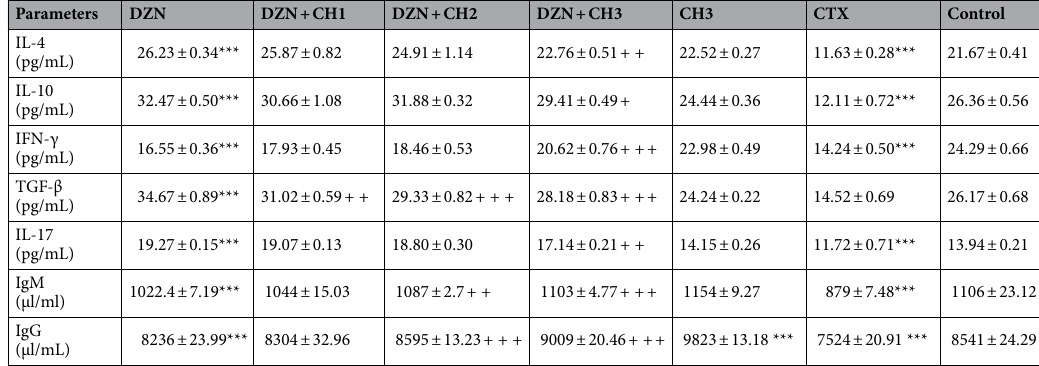
Table 4. The results of DZN 20 mg/kg, CH 50 mg/kg, and CH and DZN plus CH (12.5, 25, and 50 mg/ kg) on cytokine and total IgM and IgG production in BALB/c mice. Data showed as mean ± SD, (*) shows the significant changes compared to controls ( +) comparison with DZN-treated group. p < 0.05 and (***) or (+ + + +) p < 0.001. Cytokines measurement in the DZN group showed that the production of IFN-γ in the DZN group was significantly down-regulated compared to the control group. However, the significant impact of CH on the neutralisation of toxicity effects of DZN on IFN-γ was dose-dependent and only taken at the highest concentration of CH 50 mg/kg.